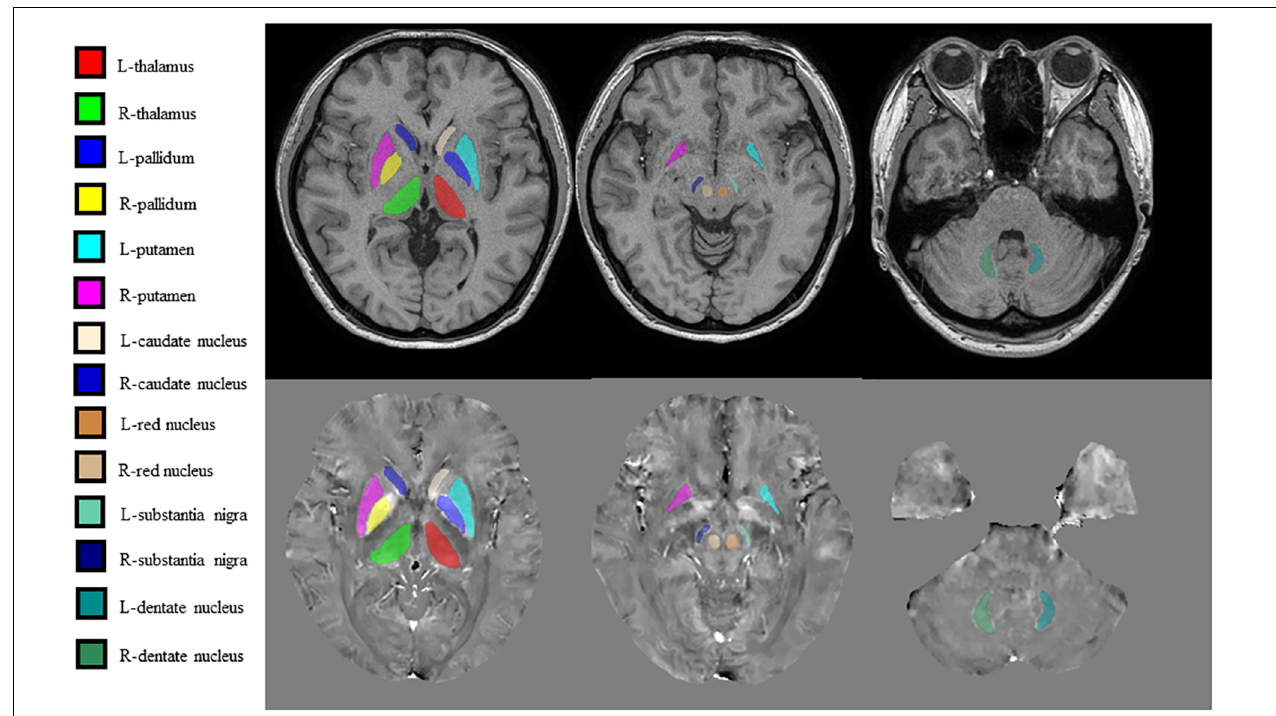
FIGURE 1 | Regions of interest (ROIs) were traced directly on the quantitative susceptibility mapping (QSM) image and T1-weighted (T1W) images to remove veins with high positive susceptibility values on QSM.